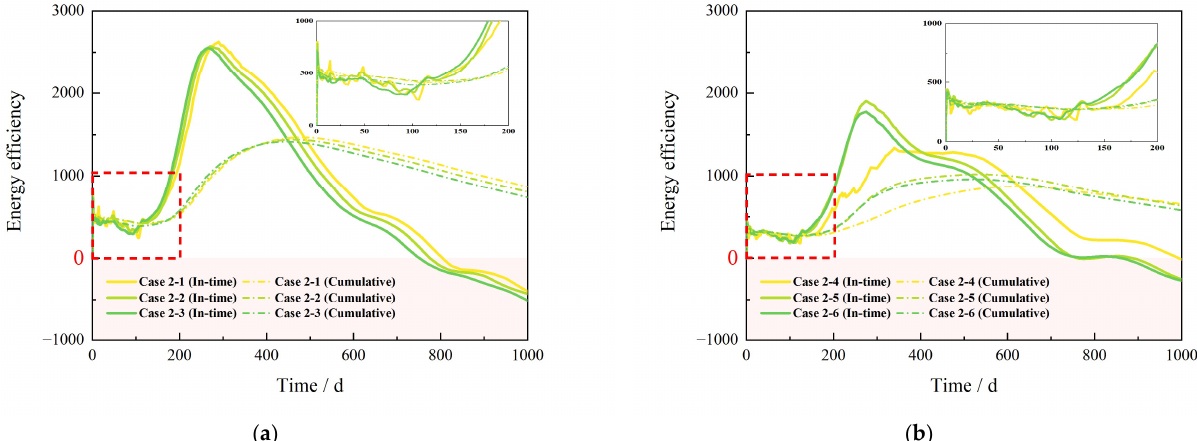
Figure 9. Energy efficiency characteristics for the inner wall heating: ( a ) P = 1 MPa; ( b ) P = 4 MPa.